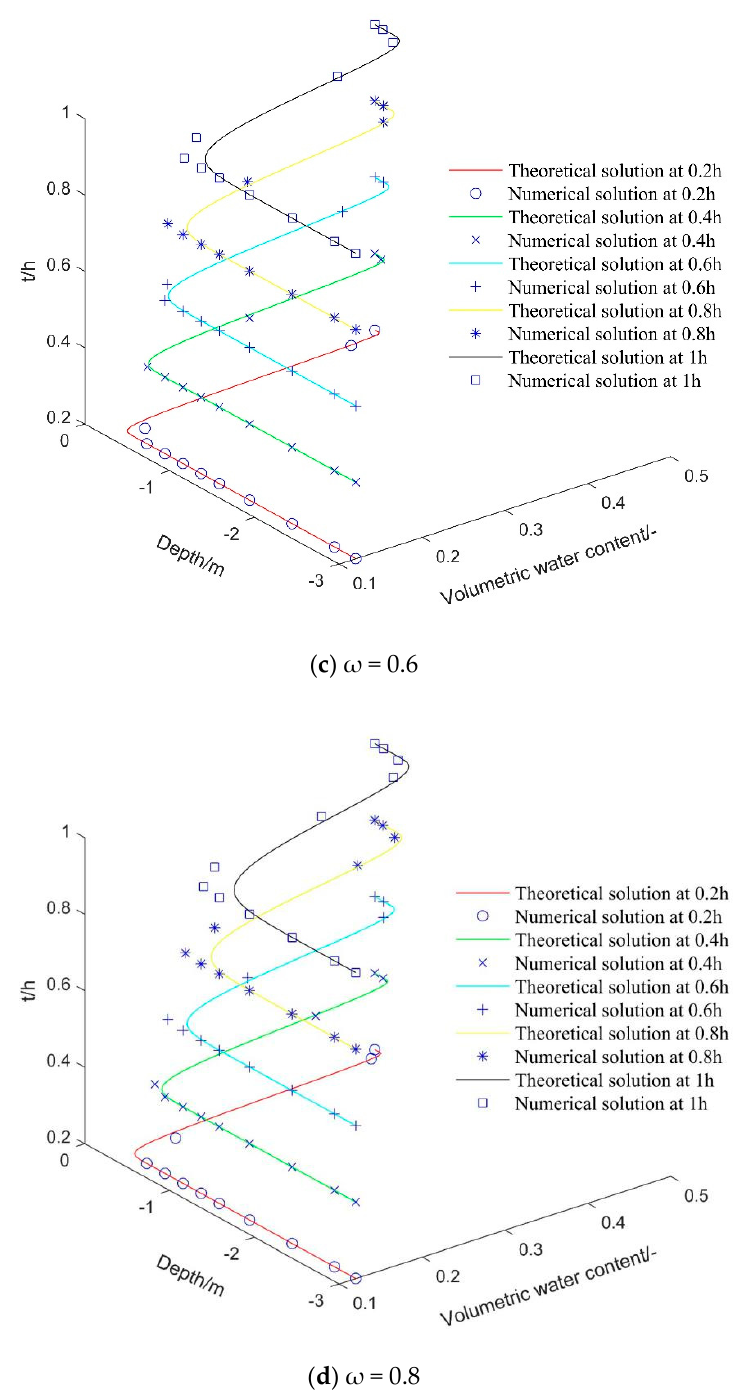
Figure 7. Result comparisons of theoretical and numerical solution for different ω .